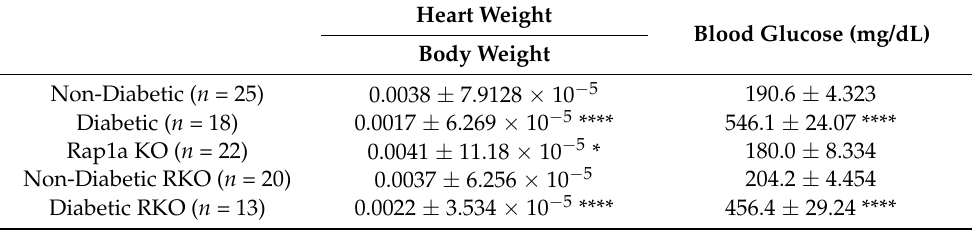
Table 1. Physiological measurements of mice utilized in this study. The heart weight, body weight, and non-fasting blood glucose levels were measured before isolation of cardiac fibroblasts. The data presented consist of the mean ± SEM, and n value indicates number of mice used where 2–3 mouse hearts were used per cardiac fibroblast isolation. Statistical analysis consisted of one-way ANOVA followed by a Dunnett’s post hoc compared to non-diabetic mice (* p < 0.05 and **** p < 0.0001). Heart Weight Blood Glucose (mg/dL) Body Weight Non-Diabetic ( n =